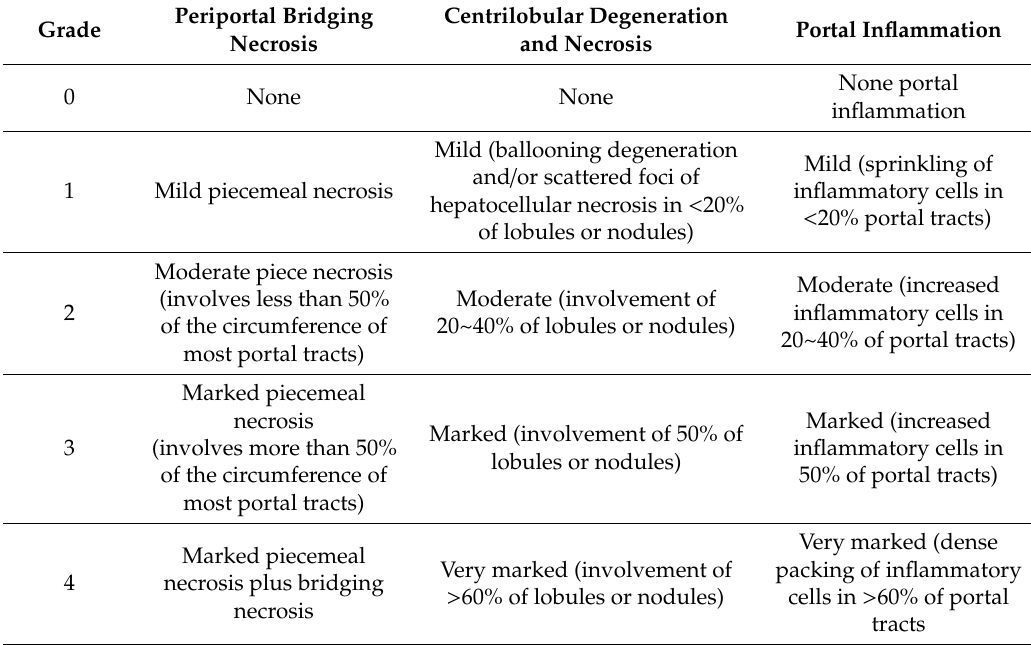
Table 1. Histological scoring